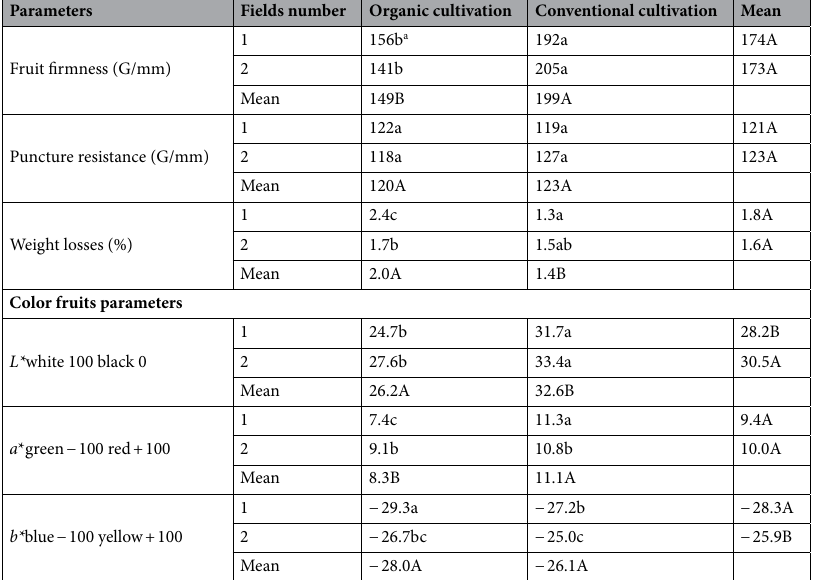
Table 4. Differences in the quality and colour of highbush blueberry fruit after CA cold storage, depending on the cultivation method. a For explanation, see Table 3.